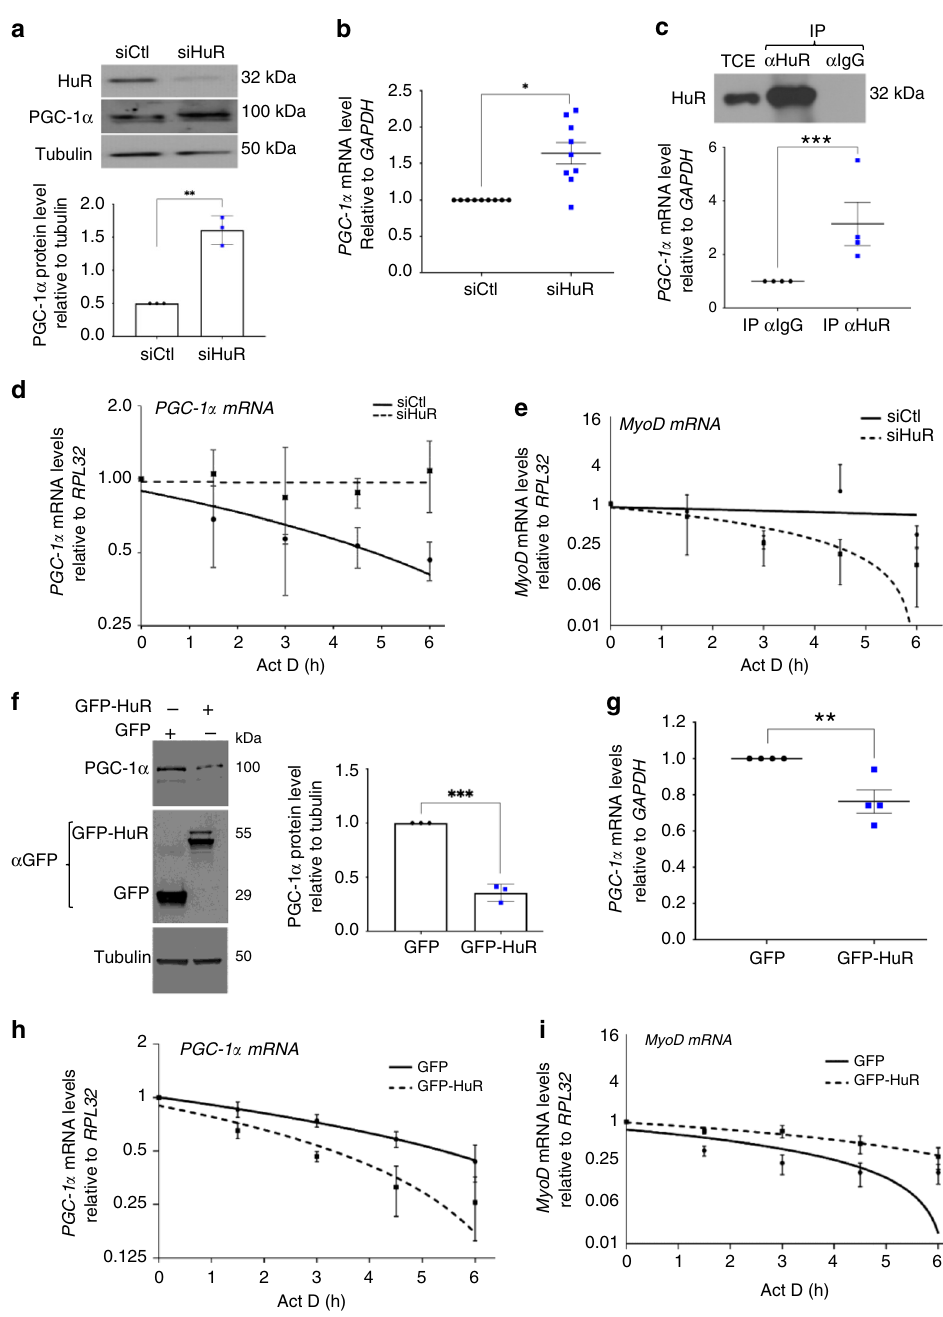
Fig. 6 HuR destabilizes the PGC-1 α mRNA in muscle cells. a Western blot (top panel) and relative quanti fi cation (bottom panel) of PGC-1 α protein levels in myoblasts treated with or without siHuR using antibodies against PGC-1 α , HuR, or α -tubulin ( n = 3). b Total RNA was isolated from myoblasts treated as in a and PGC-1 α expression was assessed by RT-qPCR. PGC-1 α mRNA level were standardized against GAPDH and plotted relatively to siCtl ( n = 9). c Top panel: western blot showing the immunoprecipitation (IP) of HuR using an anti-HuR antibody (3A2) or IgG as control. (Bottom panel) RT-qPCR were used to determine the association of the PGC-1 α mRNA to HuR. Normalized PGC-1 α mRNA levels were plotted relatively to the IgG control ( n = 4). d , e The stability of the PGC-1 α ( d ) and MyoD mRNAs ( e ) was determined in myoblasts depleted (siHuR) or not (siCtl) of HuR and treated with Actinomycin D (ActD) for 0, 1.5, 3, 4.5, or 6 h ( h ). mRNA levels were then standardized against RPL32 mRNA levels and plotted relative to the abundance of mRNA at time 0 of ActD treatment (which is represented as 1) ( n = 3). The line of best fi t was determined by linear regression using the data points for siCtl and siHuR. Error bars represent ± S.E.M. f Western blot (left panel) and relative quanti fi cation (right panel) of PGC-1 α protein levels in myoblasts expressing GFP or GFP-HuR using antibodies against PGC-1 α , GFP or α -tubulin ( n = 3). g Total RNA was isolated from myoblasts overexpressing or not HuR (GFP-HuR) and relative PGC-1 α expression was assessed by RT-qPCR. PGC-1 α mRNA level were standardized against GAPDH and plotted relatively to siCtl ( n = 4). h , i Myoblasts expressing GFP or GFP-HuR were used to assess the stability of the PGC-1 α ( h ) and MyoD ( i ) was determined as described in panels d , e ( n = 3). For d , e , h , i the line of best fi t was determined by linear regression using the data points for siCtl and siHuR. Error bars represent ± S.E.M. The results in b , c , f , g are presented as mean ± S.E.M, * p < 0.05, ** p < 0.05, *** p < 0.005 unpaired t -test. Source Data for all panels are provided in the Source Data